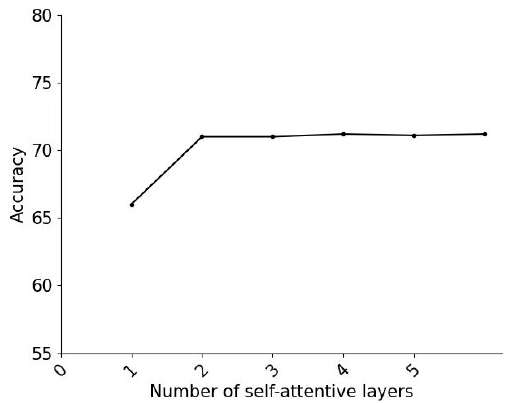
Figure 7. Accuracy changes with the number of self-attention layers.